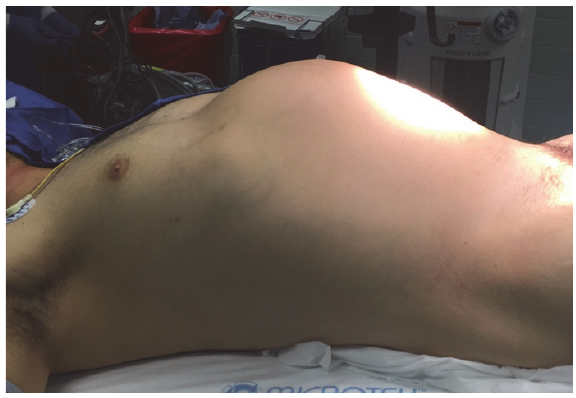
Figure 1: Abdominal mass on physical